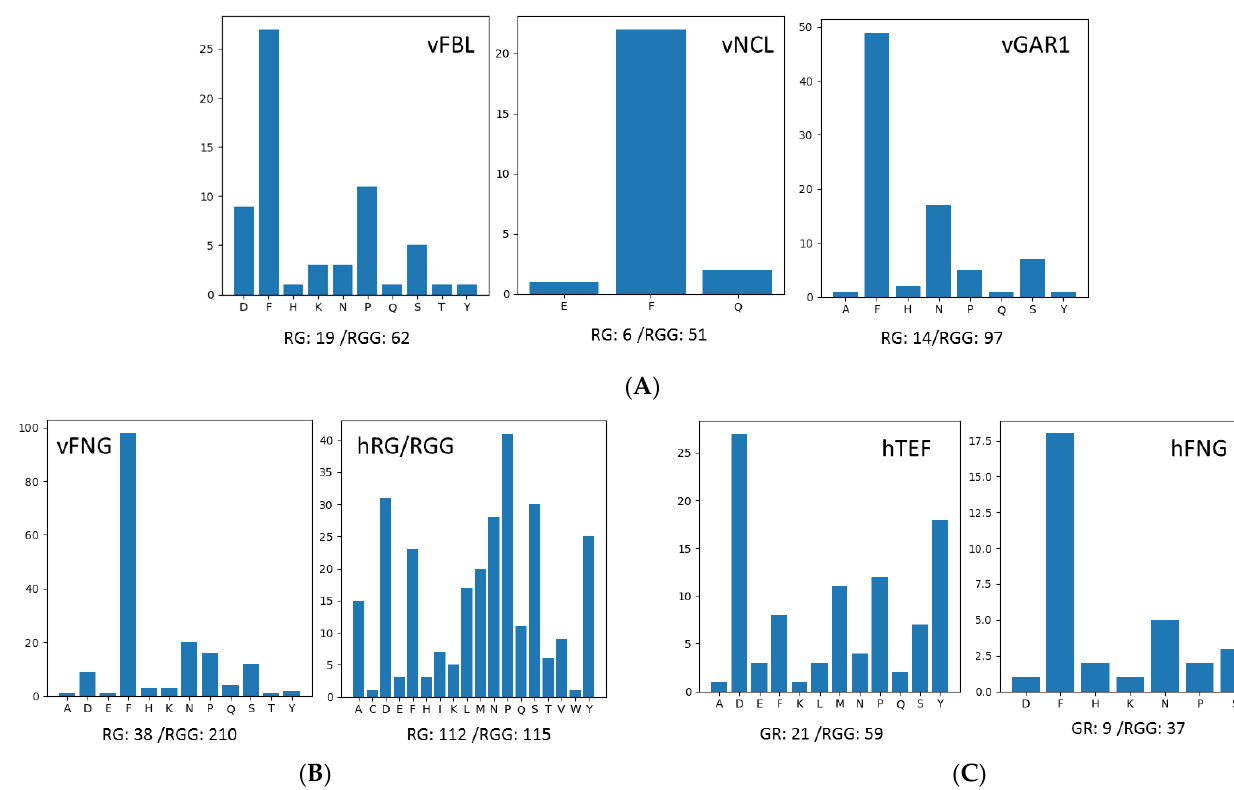
Figure 2. The distribution pattern of non-GR amino acids in the GAR domains. GMF output of the distribution of non-GR amino acids in the GAR domains of specific protein groups. The total numbers of RG or RGG repeats in the GAR domains of the protein groups are shown under the bar graph. ( A ) The distribution pattern of non-GR amino acids in the GAR domain of 3 nucleolar protein FBL, NCL, and GAR1 from 5 vertebrate model organisms (FBL, NCL, and GAR1). ( B ) The non-GR amino acids in the GAR domains of the three nucleolar proteins from the 5 model vertebrate species (vFNG) and that in the GAR motifs of 16 human RG/RGG-repeat-containing proteins (hRG/RGG). ( C ) The non-GR amino acids in the GAR domains of human FBL together with NCL and GAR1 (hFNG) and that of the human FET family members (hFET).